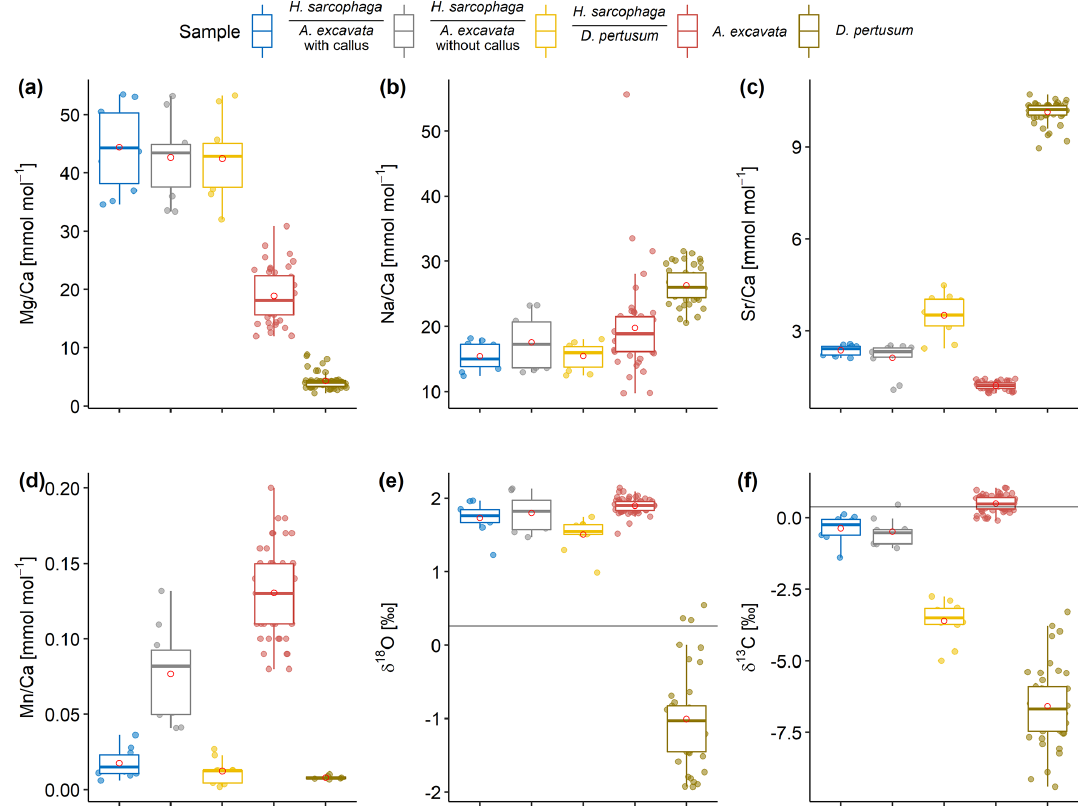
Figure 5. Box and whisker plots displaying the E / Ca (ICP-OES and ICP-MS) and stable isotope analysis (MS) of the investigated speci- mens. Boxes display the interquartile range and lines the median values. The whiskers show minimum and maximum values that are within the range of Q1 − 1.5 × IQR to Q3 + 1.5 × IQR. Red circles show mean values. Lines in panels (e) and (f) show the isotopic composition of the ambient seawater. Text below the horizontal lines in the legend is the host organism that H. sarcophaga grew